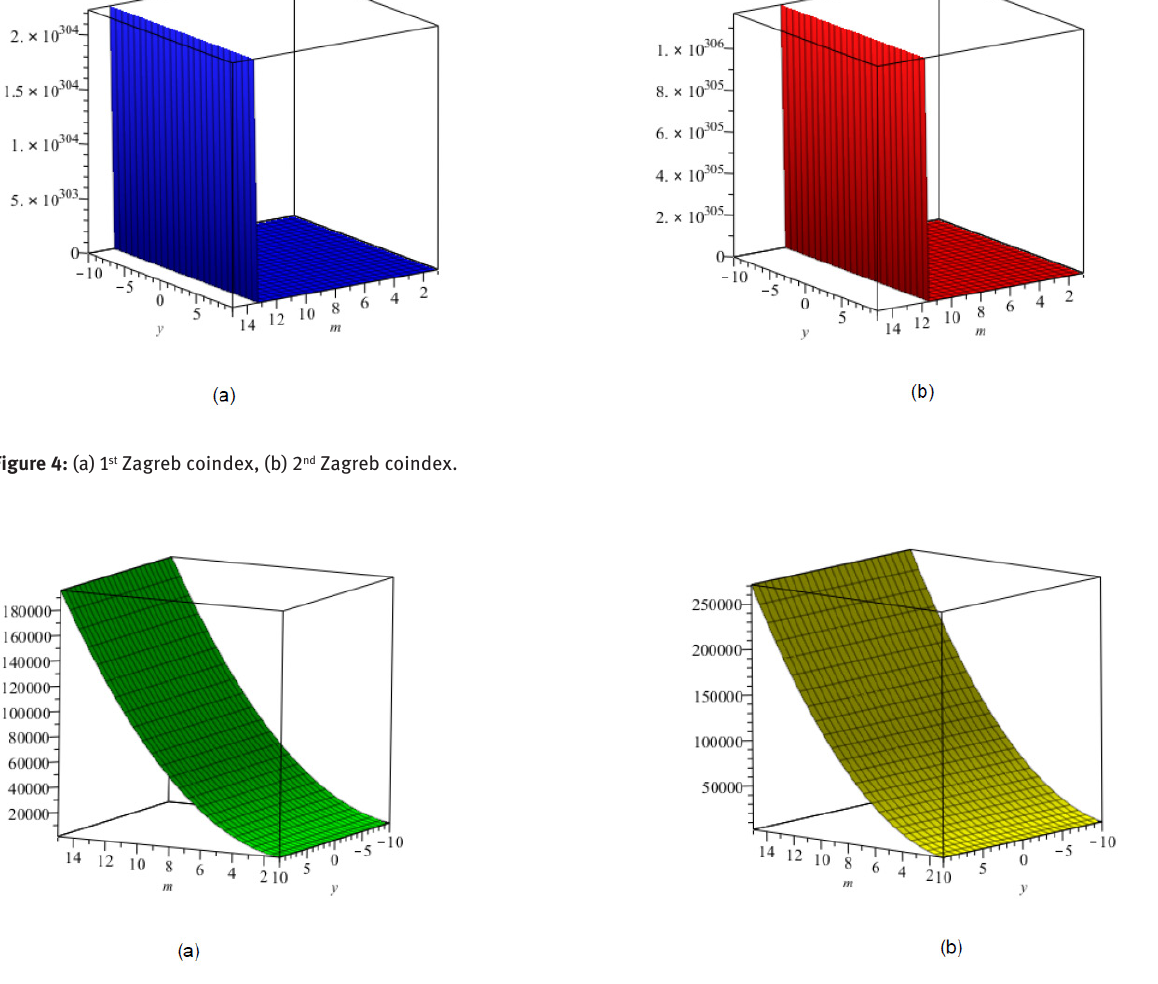
Figure 5: (a) First Multiple Zagreb index (b) Second Multiple Zagreb